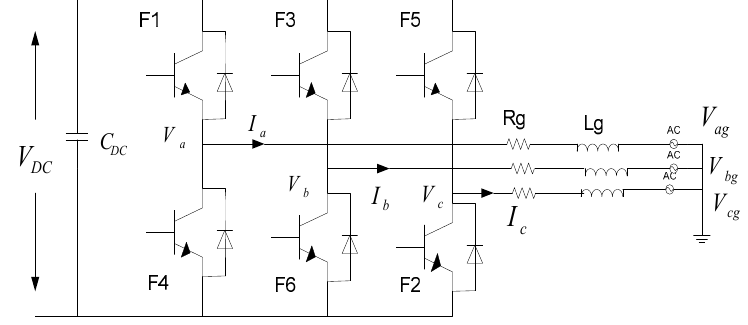
Figure 3. Voltage source converter (VSC) for the PV source.